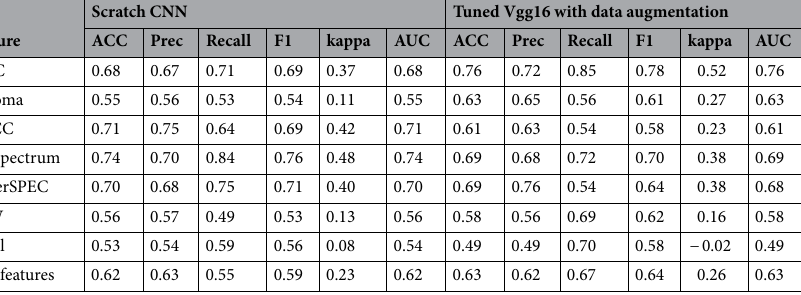
Table 4. Classification performance per measure per classifier (CNN from scratch and tuned Vgg16 with data augmentation) after 100 training